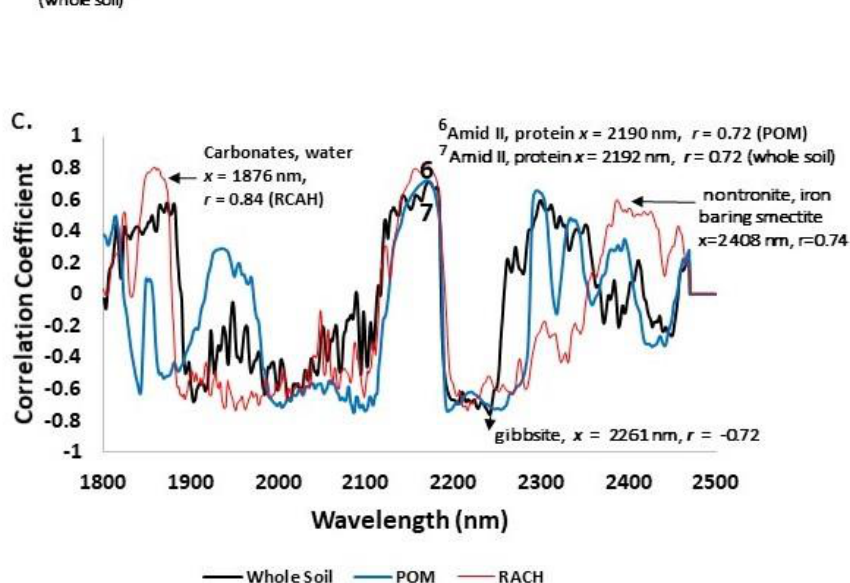
Figure 2. ( a – c ) Correlograms of the correlation ( r , y -axis) and reflectance at a given wavelength ( x -axis) with whole soil (C or N), POM (N or C), or RACH containing wavelengths that correlated with mineral and organic components. Measurements were taken using a spectroradiometer. Correlograms of the correlation and reflectance at a given wavelength were compared to the published literature [17,30]. Whole soil, POM, and RCAH contained iron bearing minerals (Table 6 and Figure 2), all three dominant soil series in the watershed treatments contained iron oxides and active to super-active clay